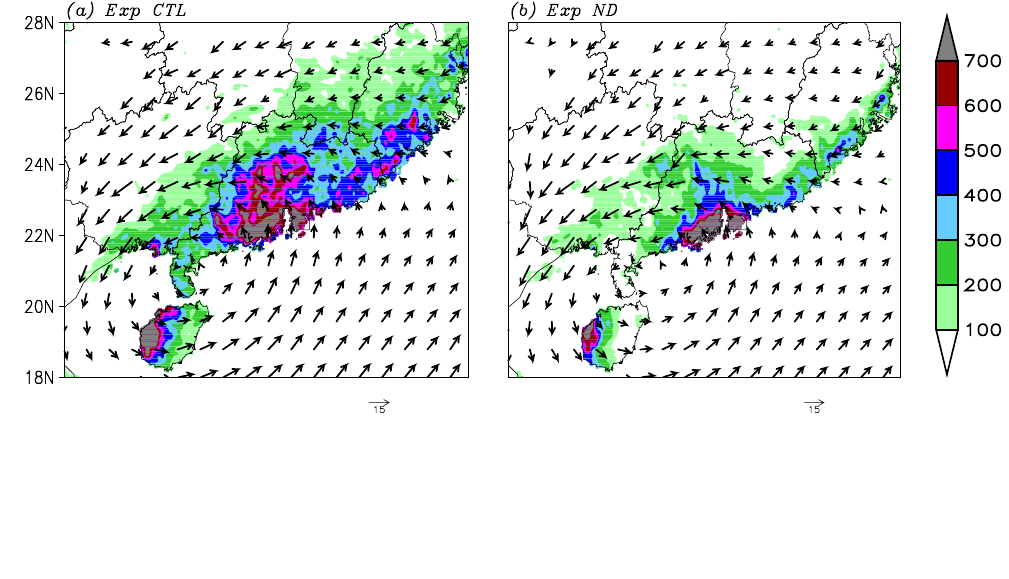
Figure 8. The simulated 10-day total rainfall (shaded, unit: mm) and mean 900-hPa wind (vectors, unit: m·s –1 ) by Exps ( a ) CTL, ( b ) ND, ( c ) NT and ( d )